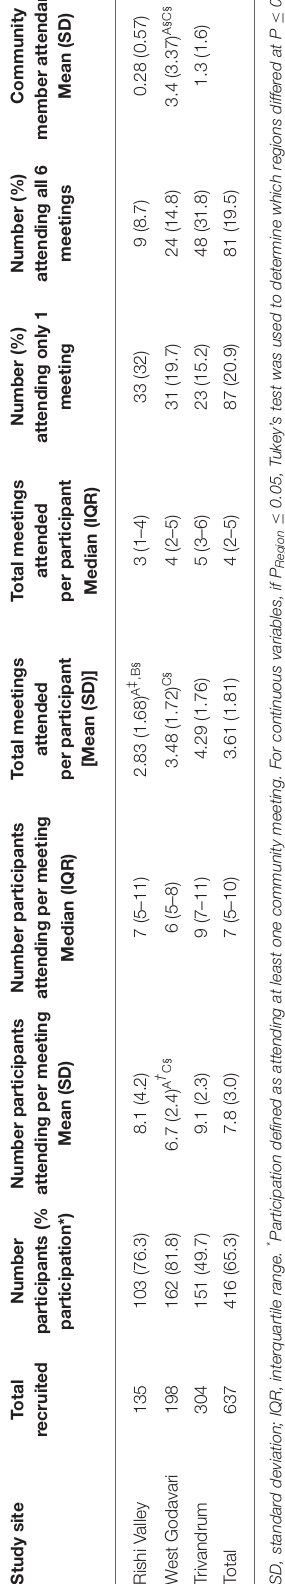
TABLE 2 | Meeting duration by study